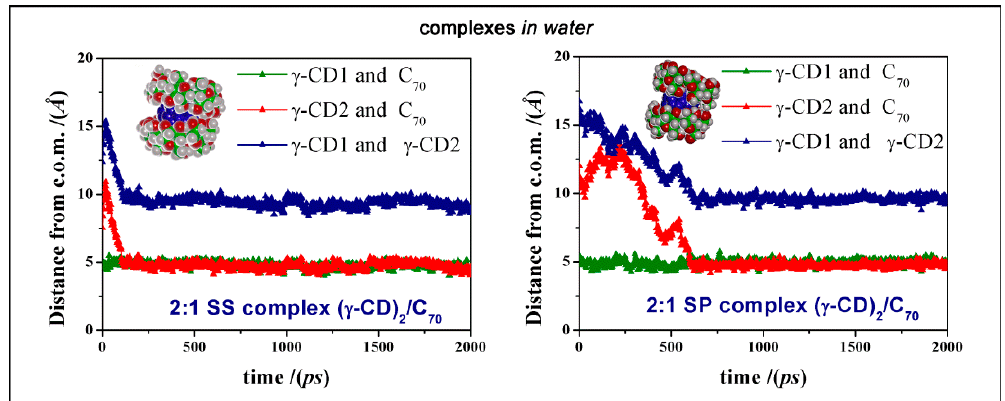
Figure 7. The same as in Figure 6 at left for the SS and SP [( γ -CD) 2 /C 70 ] complexes.